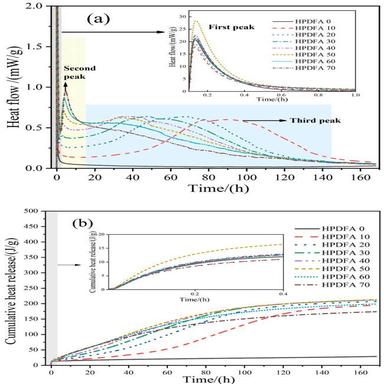
(a) The Heat flow curve of specimens with different HPFA dosage. (b) The cumulative heat release curve of specimens with different HPFA dosages.